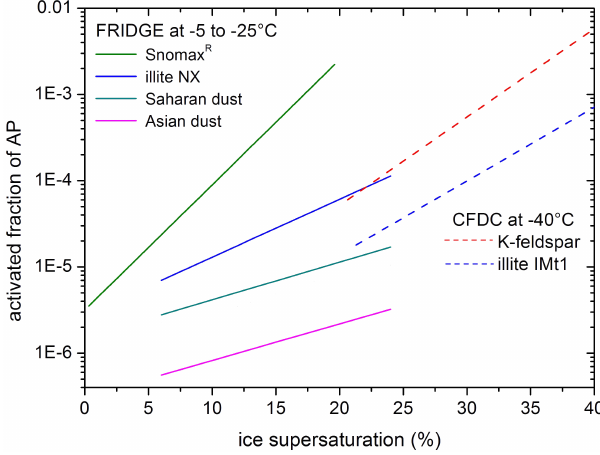
Figure 5. Activated fraction of particles in the deposition freezing mode as a function of ice supersaturation for Saharan and Asian dust. Data from K. Ardon-Dryer and Z. Levin (personal communi- cation, 2012).